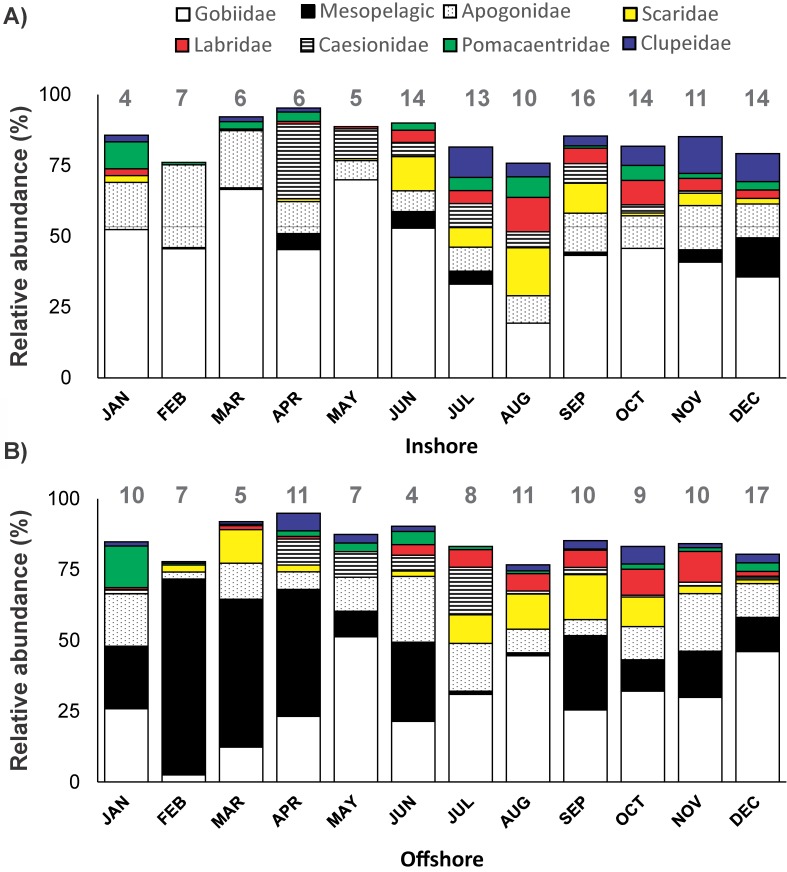
Relative abundance of the major families.The % contribution of the eleven major families in the monthly collections of the inshore (A) and offshore (B) station. Mesopelagic category includes species belonging to the families Phosichthyidae, Myctophidae, Bregmacerotidae, Paralepididae and Stomiidae. Values on the top of each bar correspond to the numbers of the rest of the families encountered in the samples.